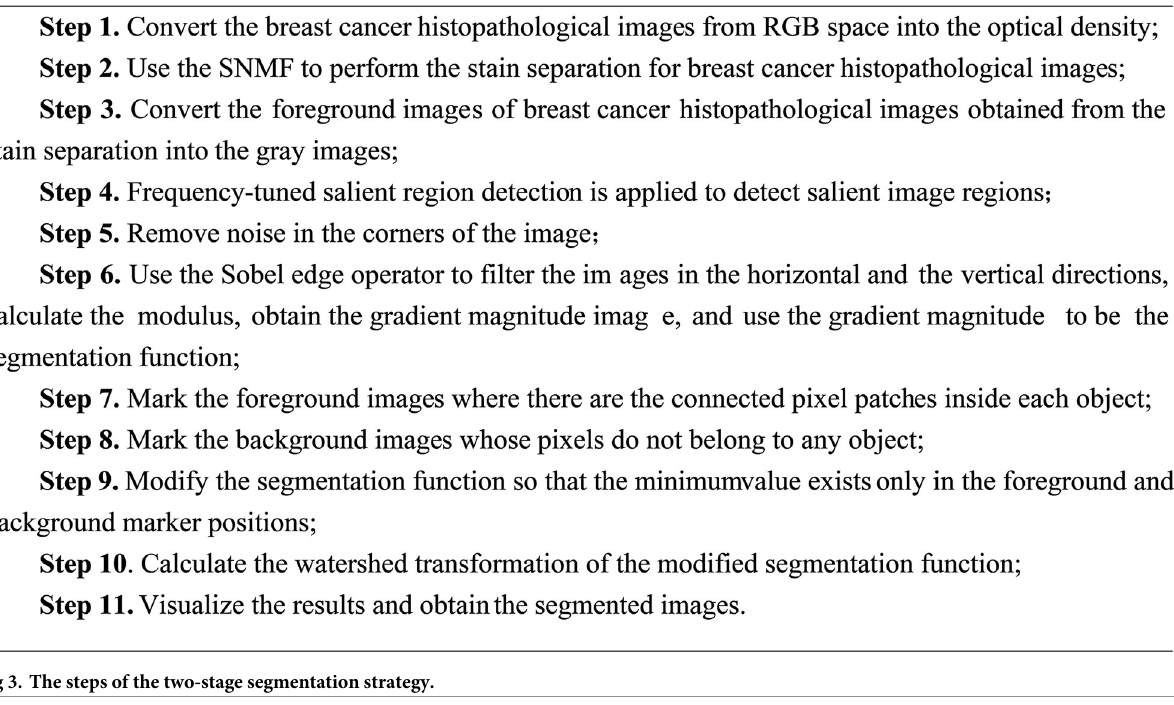
Fig 3. The steps of the two-stage segmentation